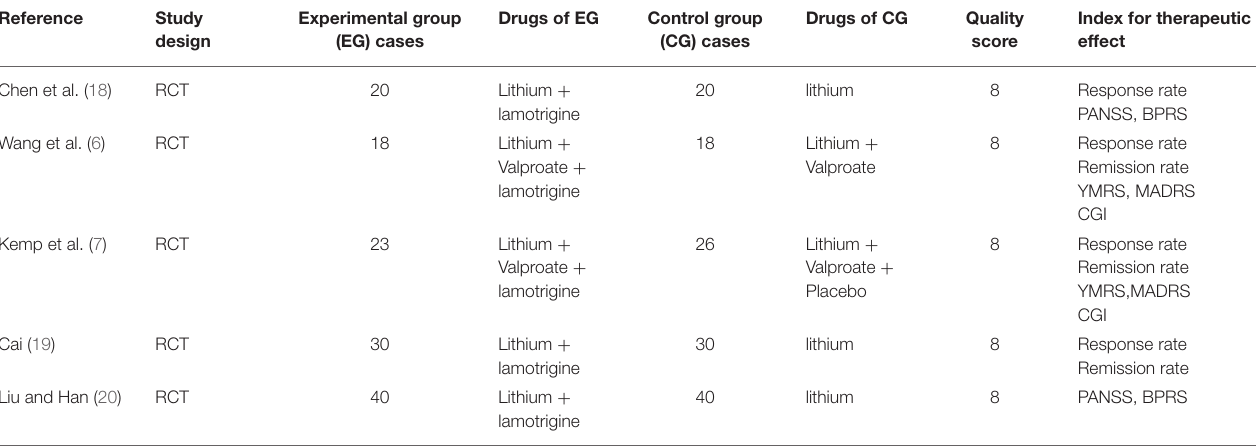
TABLE 1 | Characteristics of studies included in the